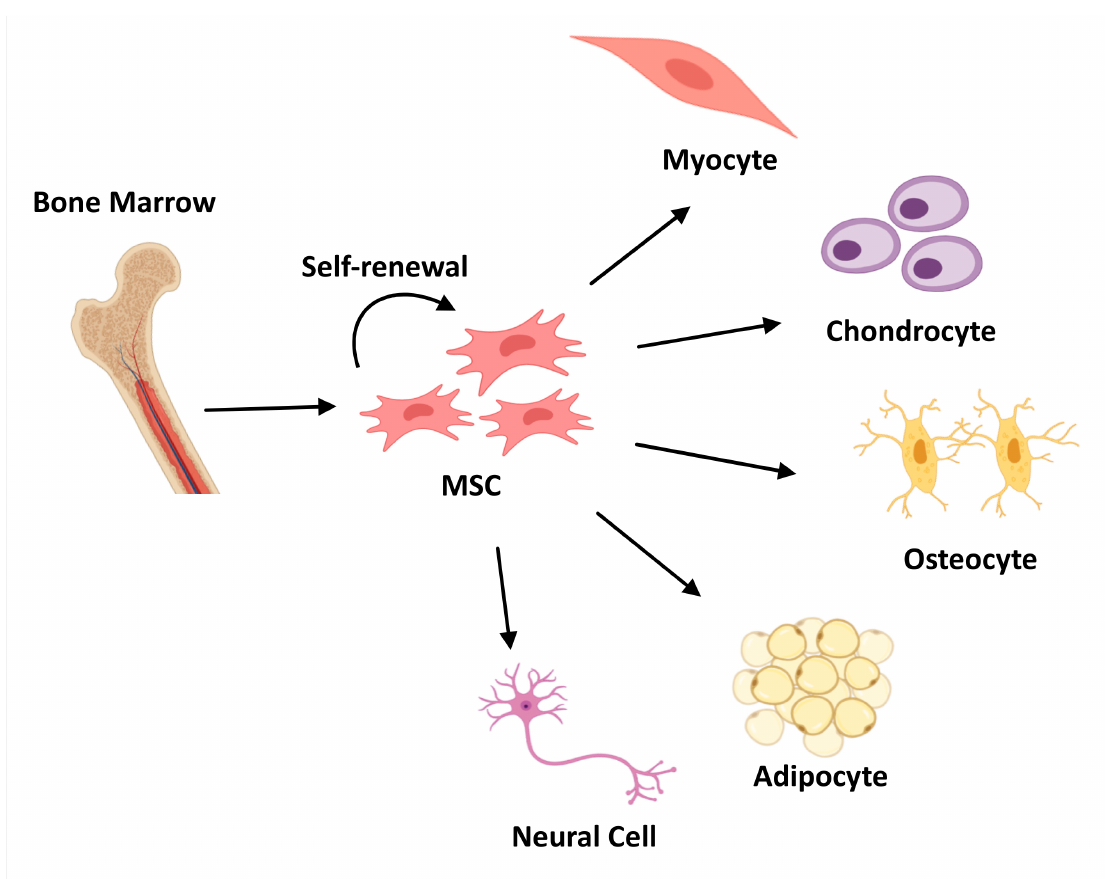
Figure 2. Schematic representation of Mesenchymal Stem Cells (MSCs) di ff erentiation process into three di ff erent lineages: Myocytes, Chondrocytes, Osteocytes, Adipocytes, and Neural